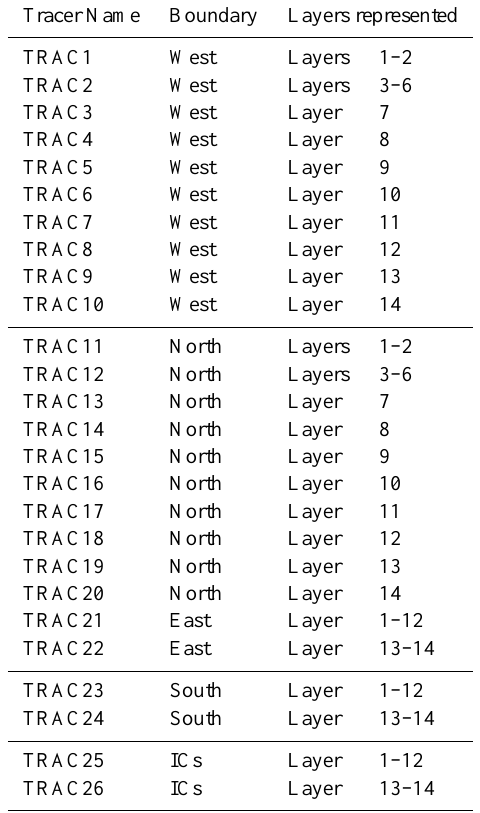
Table 4. Definition of tracers used in tracer